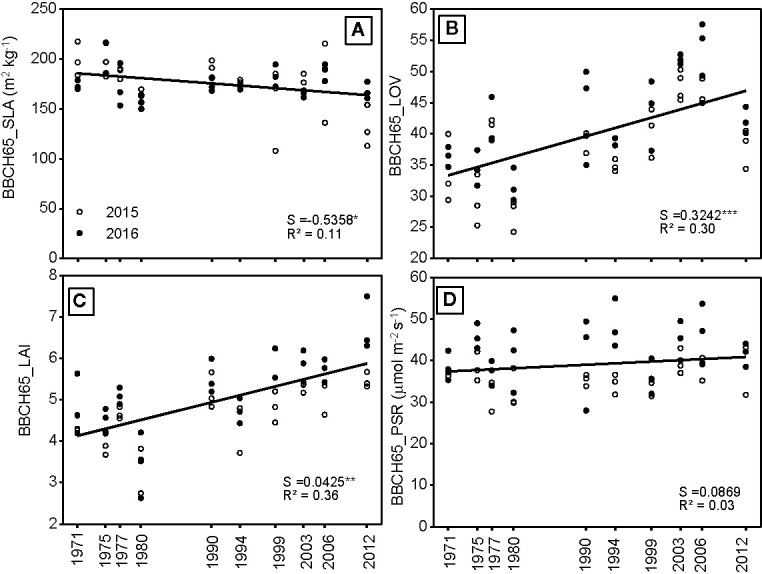

(A) Specific leaf area (average over measurement levels), (B) LOV, (C) LAI, and (D) photosynthetic rate at flowering measured on three plants per plot from 10 different hybrids, which were released in the period between 1971 and 2012 and either grown in 2015 or 2016. S = slope of the regression. The regression indicates differences among hybrids across the year of registration. All slopes were tested to be significantly different from zero. Significance levels are: ***p < 0.001 and **p < 0.01, R2 = pseudo R2. Values are averages from three plants per plot with three blocks.